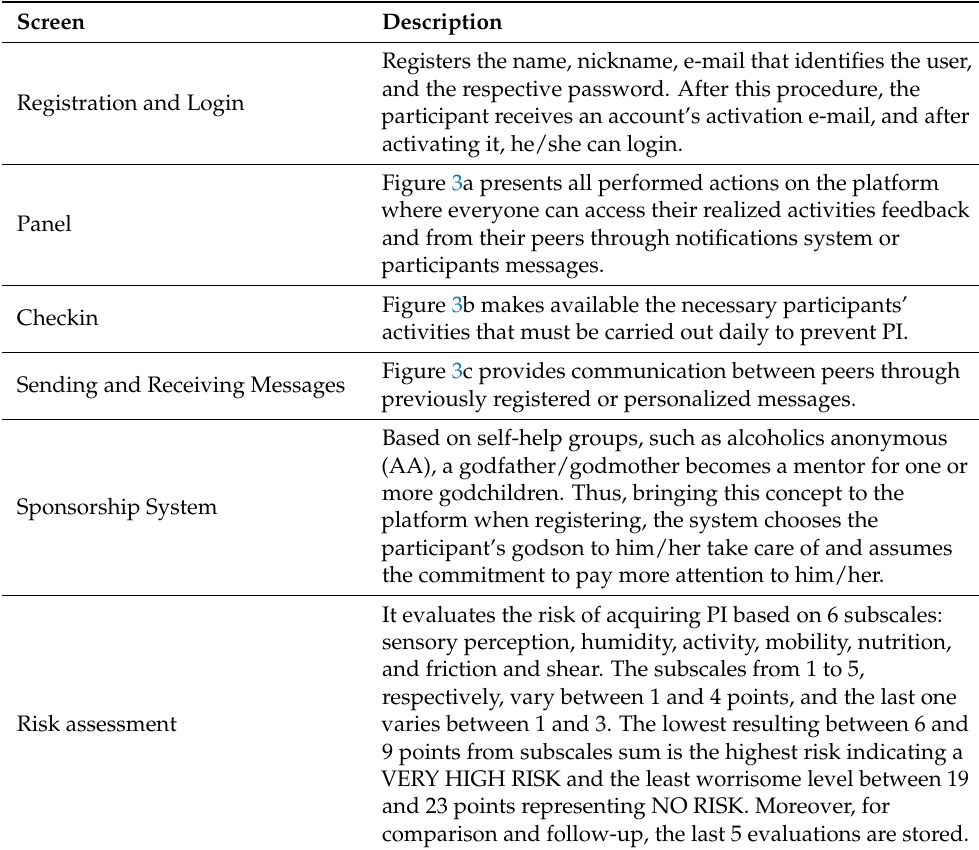
Table 3. ColaborAtiva platform